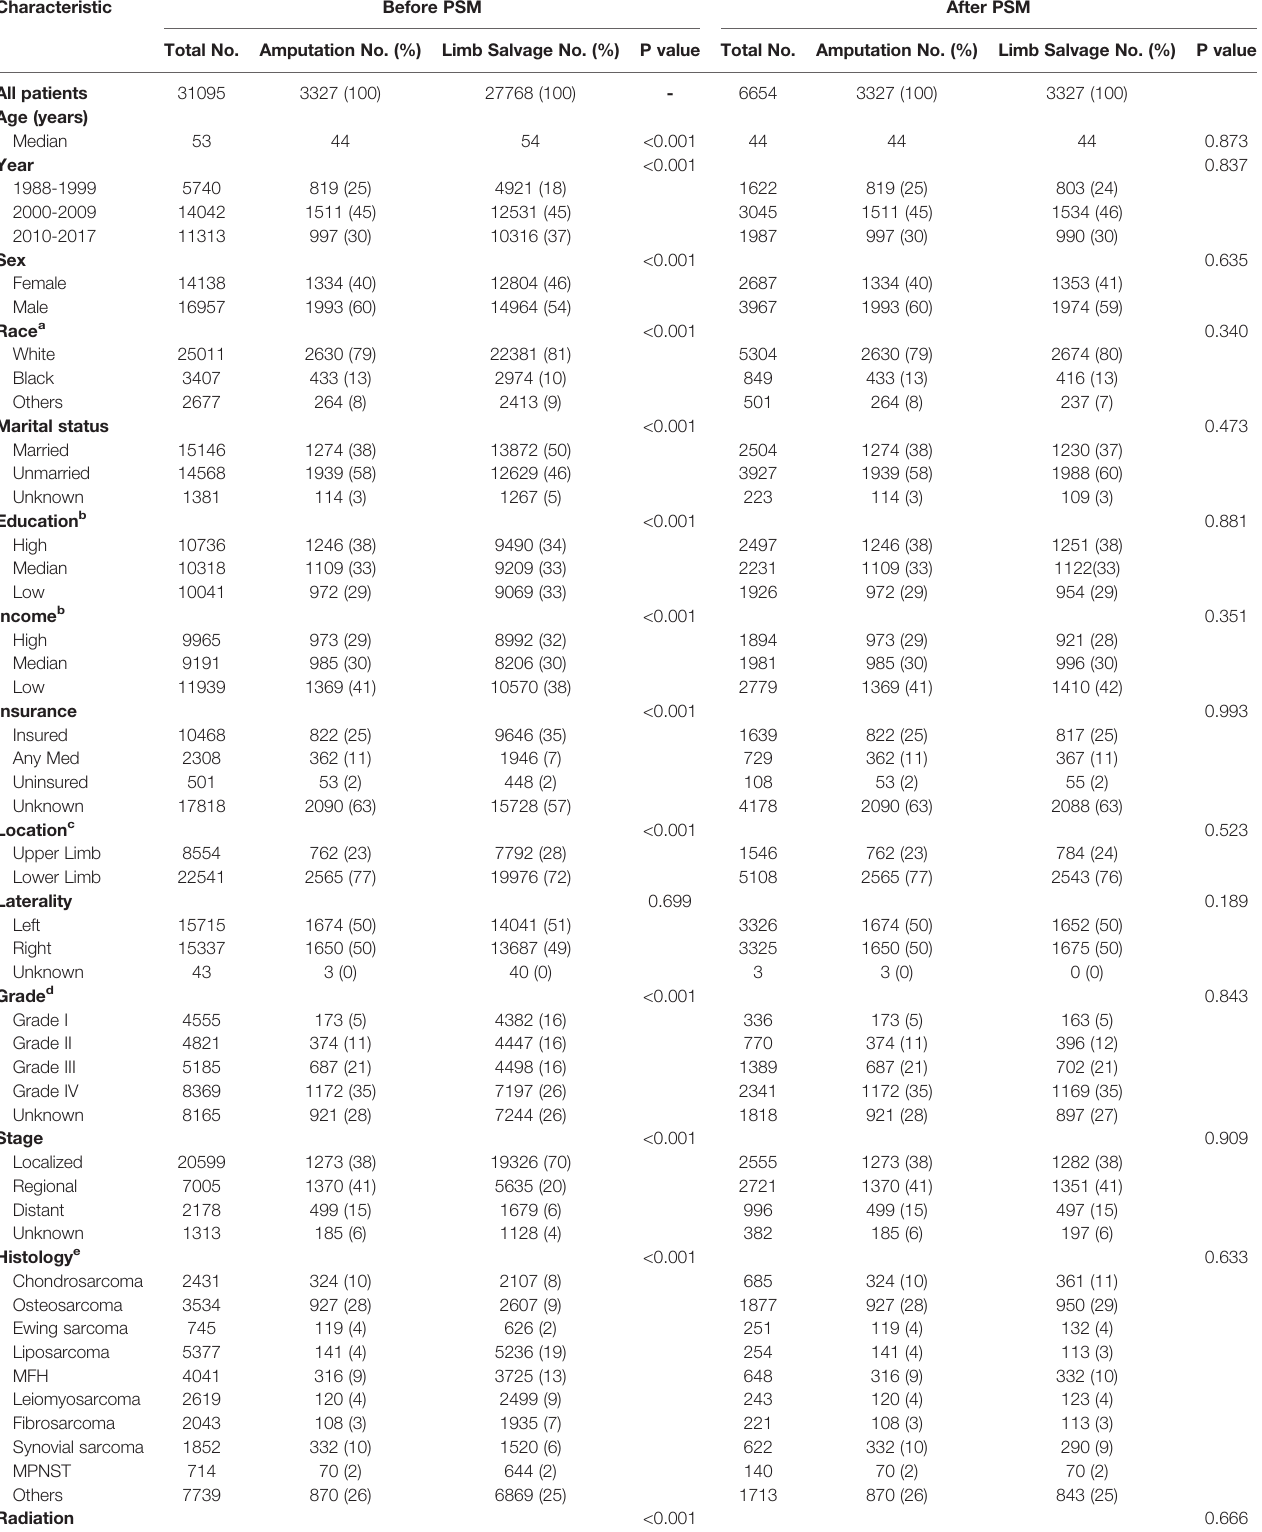
TABLE 1 | Patient information based on their baseline characteristics before and after 1:1 PSM among subgroups receiving limb salvage and amputation. Characteristic Before PSM After